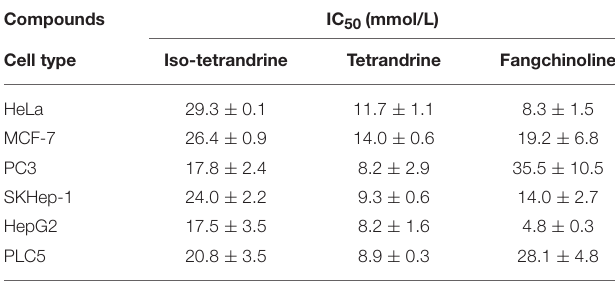
TABLE 1 | Cytotoxicity of tetrandrine and related compounds against different